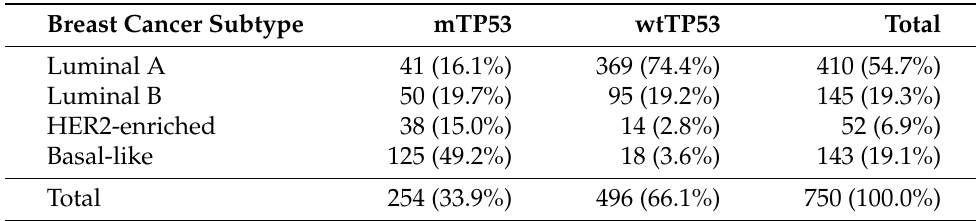
Table 1. The number and proportion (in parentheses) of breast cancer cases from TCGA and their subtypes based on the PAM50 classification [19]. The proportion represents the ratio of the cases to the entire cases of the same subtype. mTP53: breast cancer patients with somatic mutations in the TP53 gene. wtTP53: breast cancer patients with a wild-type TP53 gene. Breast Cancer